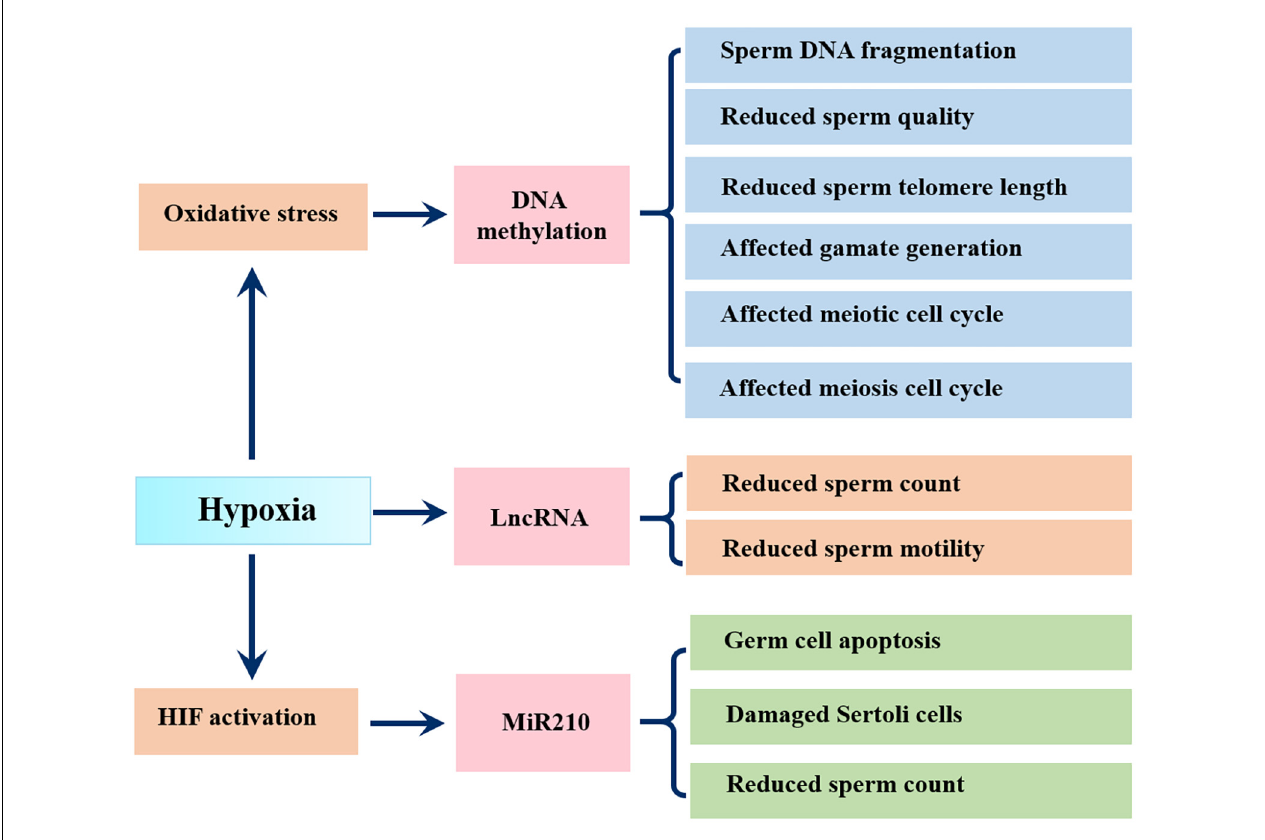
FIGURE 4 | Influence of hypoxia on epigenetic changes in sperm. Hypoxia causes oxidative stress, which changes DNA methylation in sperm, resulting in sperm DNA fragmentation, reduced sperm quality, sperm telomere length and affected gamate generation and affected meiotic and meiosis cell cycle; Hypoxia related lncRNAs show negative correlations with sperm count and sperm motility; Hypoxia activates miR210, leading to germ cell apoptosis, Sertoli cell damage and reduced sperm count.